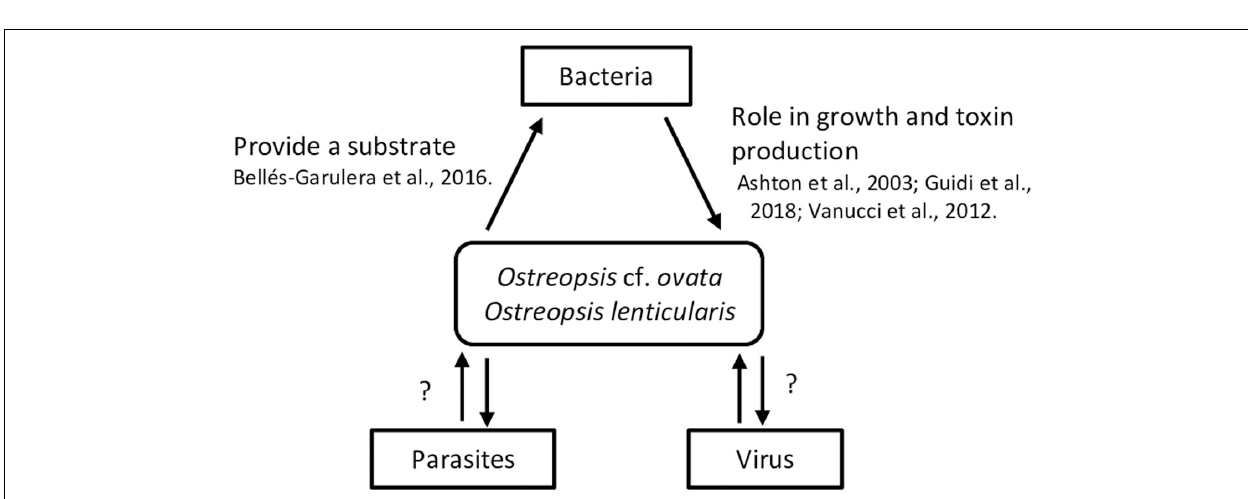
FIGURE 1 | Chemical structure of the main toxic compounds found in Ostreopsis species: (A) Palytoxin and its main analogs, the most common; and (B) Ostreol-A, present in some Korean strains.